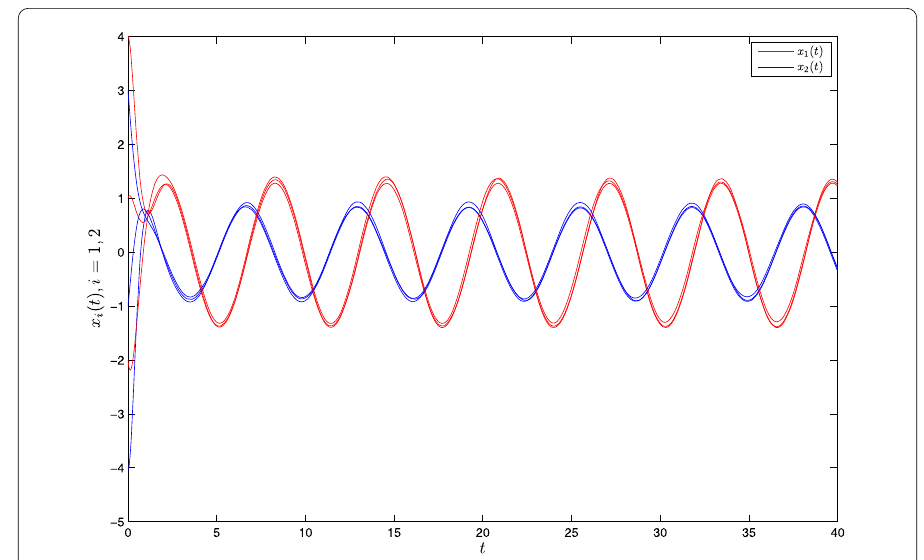
Figure 1 Numerical solutions x ( t ) on system (3.1). Numerical solutions x ( t ) to example (3.1) with initial values: (sin t + 1,–cos t – 3,cos t ,sin t ),(2cos t + 2,3sin t – 1,–2sin t ,3cos t ),(–3sin t – 2,–4sin t + 3,–3cos t ,–4cos t )